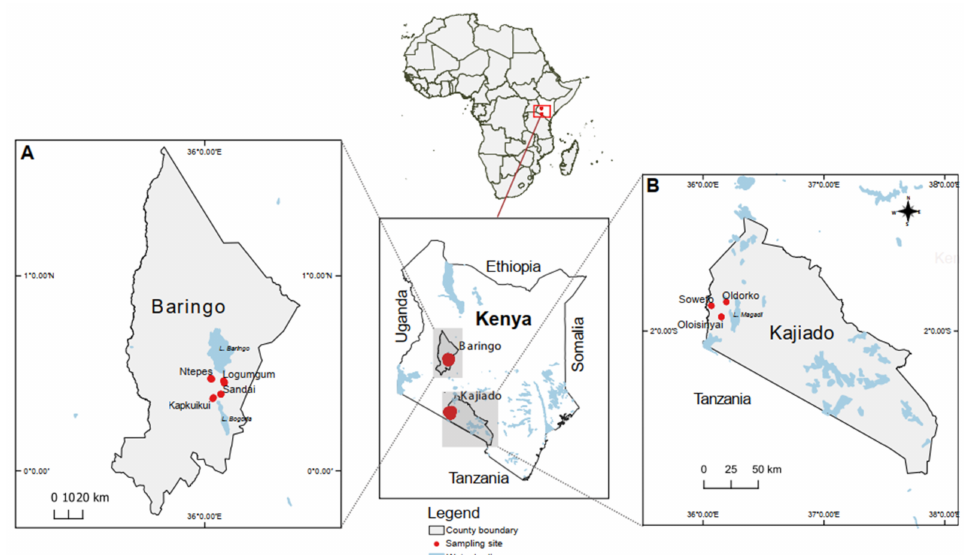
Figure 1. Map showing tick collection sites in Kenya. The red dots indicate sampling points. ( A ), location of Baringo county; ( B ), location of Kajiado county. The maps were created in the open source GIS software QGIS 2.12 using GPS co-ordinates and shape files derived from Natural Earth (http://www.naturalearthdata.com/, a free GIS data source, accessed on 20 October 2021) and Africa Open data (https://africaopendata.org/dataset/kenya-counties-shapefile/, license Creative Commons, accessed on 20 October 2021)